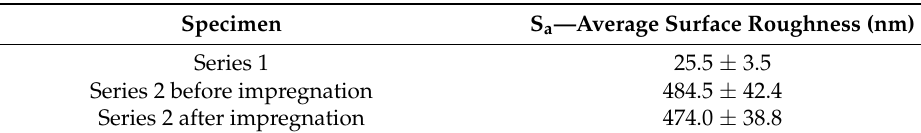
Figure 3. A drop of water on ( a ) hydrophilic surface (specimen from Series 1), ( b ) superhydrophilic surface (specimen from Series 2 before impregnation), ( c ) superhydrophobic surface (specimen from Table 1. Average surface roughness value of specimens. Series 2 after impregnation).